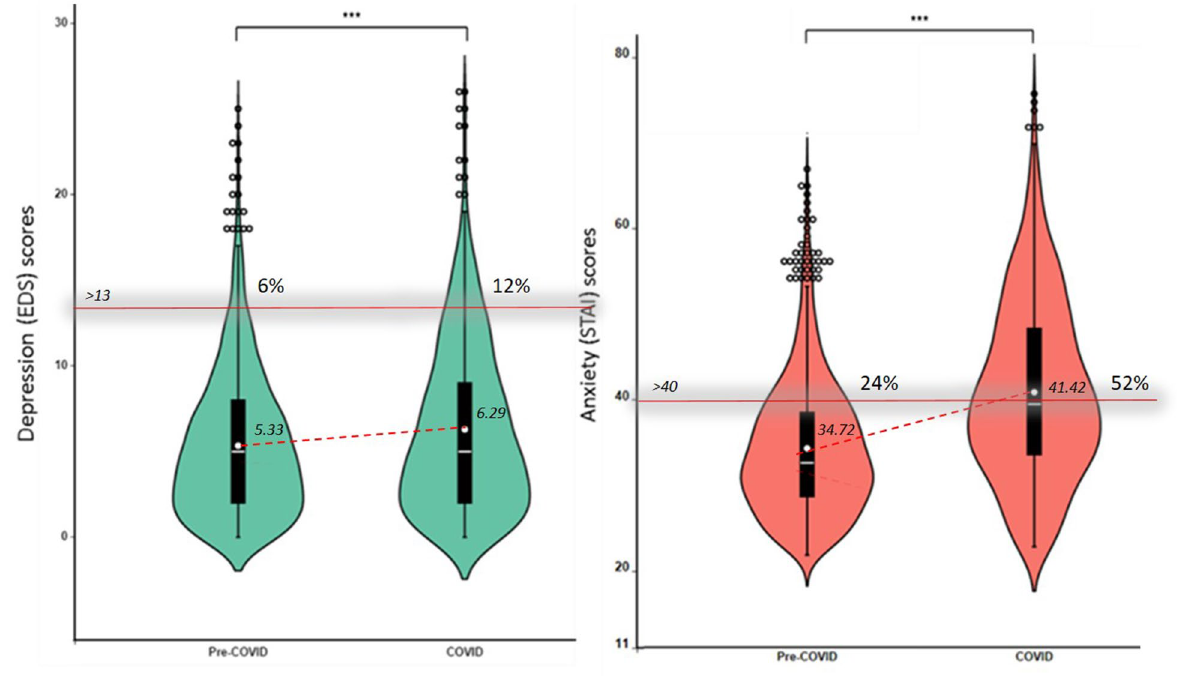
Figure 2. Violin plots illustrating the scores on depression (green) and anxiety (orange) in the pre- and during- COVID-19 samples. The distribution of the data is represented by the violin shape, with larger width indicating higher value frequency. The mean of each group is represented by the dot, whereas the horizontal bars represent the minimum, the median and the maximum values. The whiskers represent the first and the fifth quantile. The dots represent outlier scores. The percentage of women above the clinical cut-off > 13 for depression and > 40 for state anxiety in the Pre-COVID and the COVID sample is noted above the cut-off line. ***p < Figure 2 illustrates the mean with standard deviation scores for depression and anxiety in the two groups. T-test results revealed significantly higher [ t (2445) = 5.18, p < 0.001, d = 0.21 ] scores for depression in the COVID-19 sample [ M = 6.29, SE = 0.15, N = 1008], compared to the pre-COVID-19 sample [ M = 5.33, SE = 0.11, N = 1439]. Likewise, anxiety was sig-